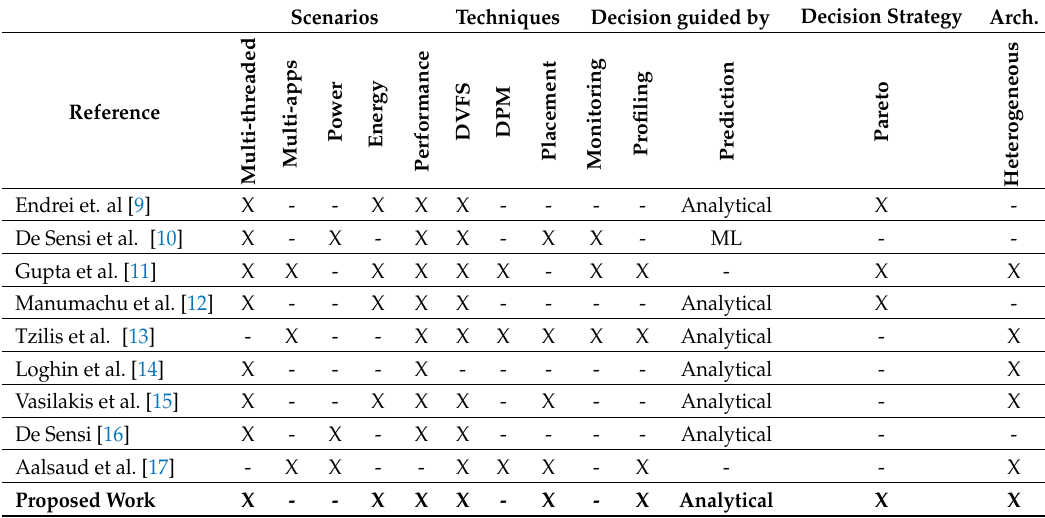
Table 1. Related work categorized by various